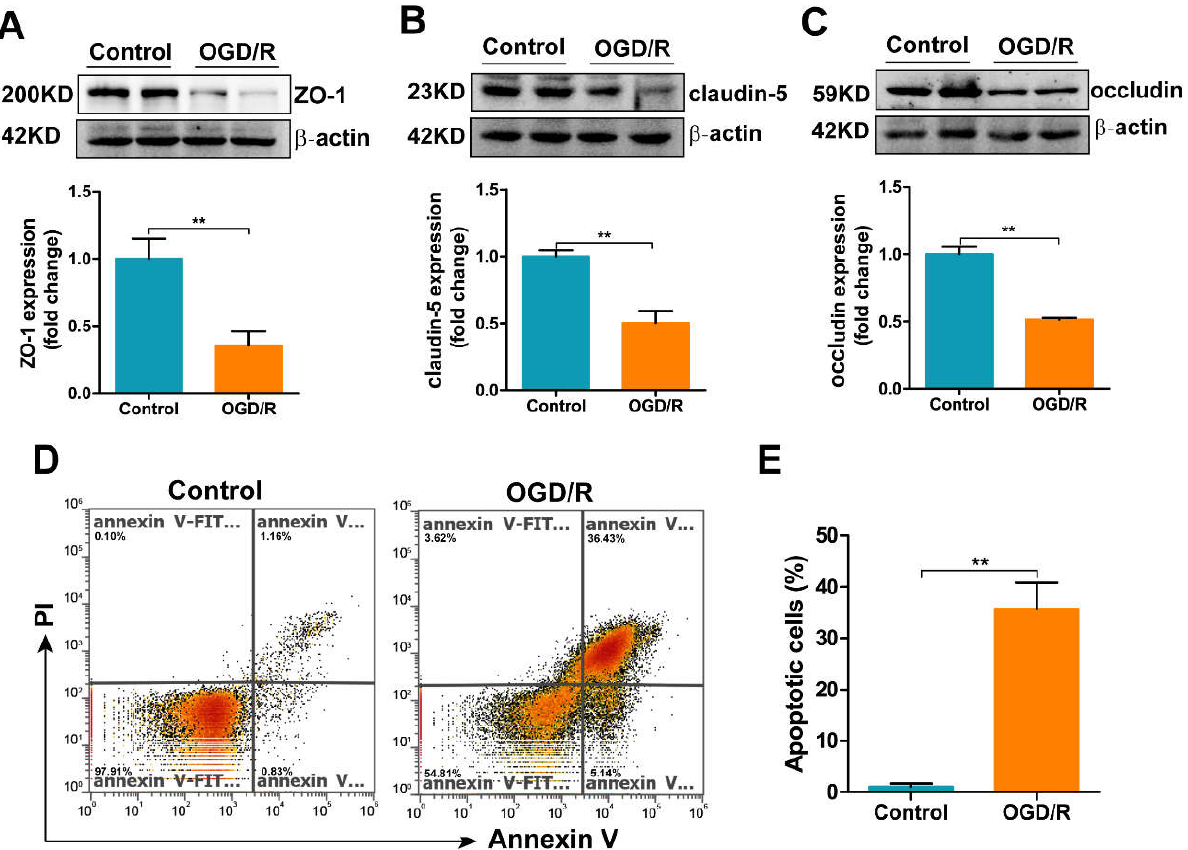
Figure 6. OGD/R induces tight junction loss and apoptosis in bEnd.3 cells. Western blot and densitometric analyses of ( A ) ZO-1, ( B ) claudin-5 and ( C ) occludin in OGD/R-treated bEnd.3 cells. The results are normalized to the β -actin levels and the data are expressed relative to the mean value in the control group ( n = 4). ( D ) Apoptosis was measured by flow cytometry; representative data from one of three experiments are shown. ( E ) Quantification of the percentage of apoptotic cells in OGD/R-treated bEnd.3 cells. The results are presented as the mean ± SEM. ** p < 0.01.